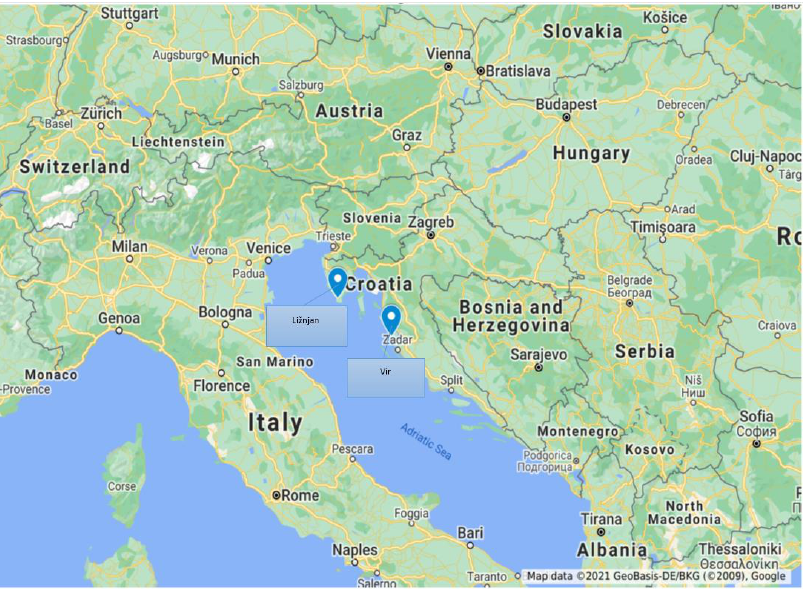
Figure 1. Map of Croatia and position of Vir and Ližnjan (adapted from Google maps).